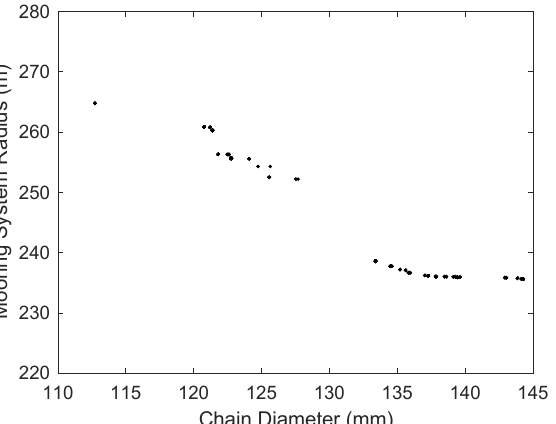
Figure 11. Mooring System Radius vs. Synthetic Line Length.